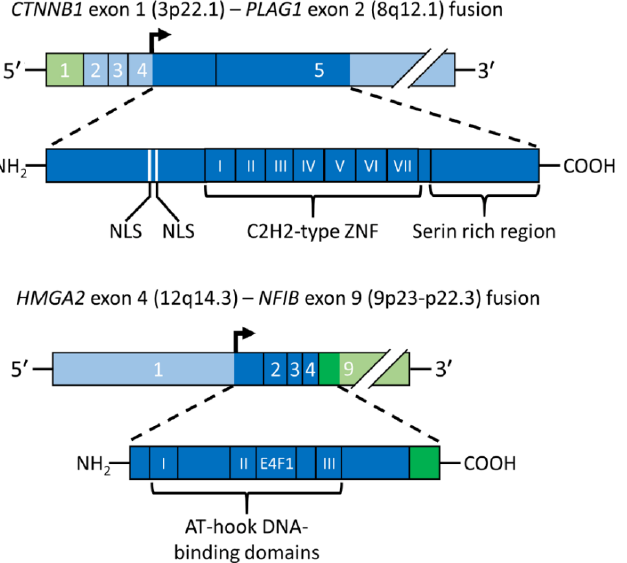
Figure 3. Schematic illustration of gene fusions in PA. The CTNNB1::PLAG1 fusion gene and the encoded fusion protein is depicted in the upper panel and the HMGA2::NFIB fusion gene and the encoded fusion protein in the lower panel. Coding exons are shown in darker green and blue and the translation start site is indicated by an arrow. AT-hook, DNA binding motif; E4F1, E4F1-domain; NLS, nuclear localization signal; ZNF, zinc finger.